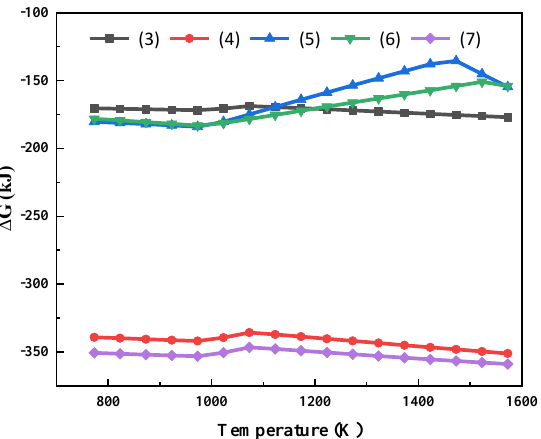
Figure 3. Gibbs free energy of the reactions (3)~(7) at different temperatures.